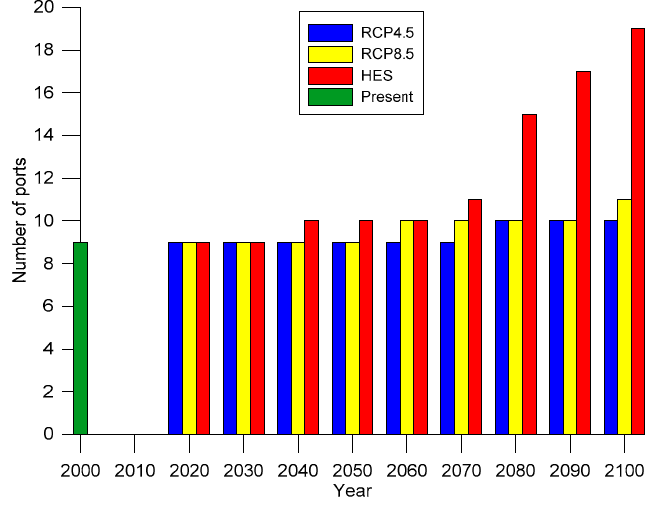
Figure 4. Number of ports with overtopping discharges greater than the tolerable ones, for the three SLR scenarios and for a return period of 50 years.